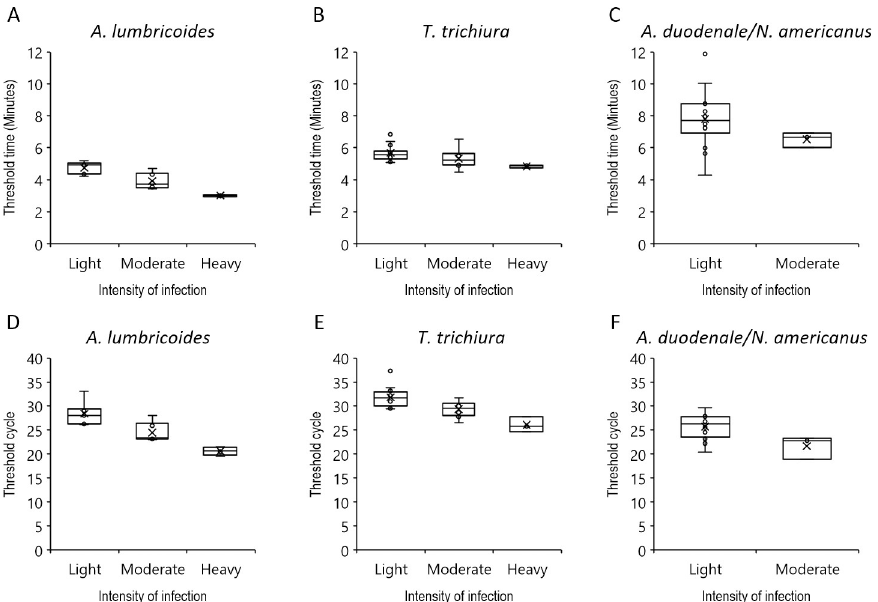
Fig 5. Correlation of RPA T t value or real-time PCR C q and intensity of infection in STH-positive stool samples with known EPG as determined by KK. Data from stool samples that were tested RPA-positive for A . lumbricoides (n = 21), T . trichiura (n = 32), and the two hookworms (n = 16). Each DNA extract was analyzed using Dx4STH (A, B and C) and real-time PCR assays (D, E and F). Threshold values were plotted against infection intensities as per KK method in a box and whisker diagram to indicate the median threshold value and